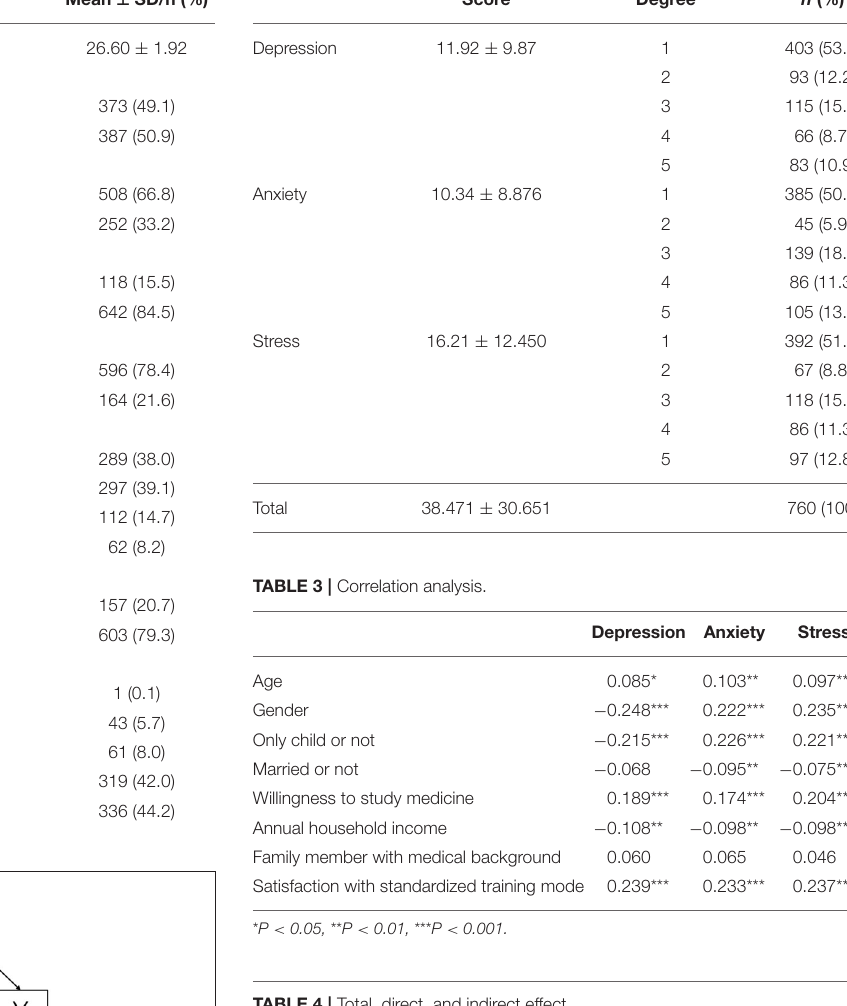
TABLE 4 | Total, direct, and indirect